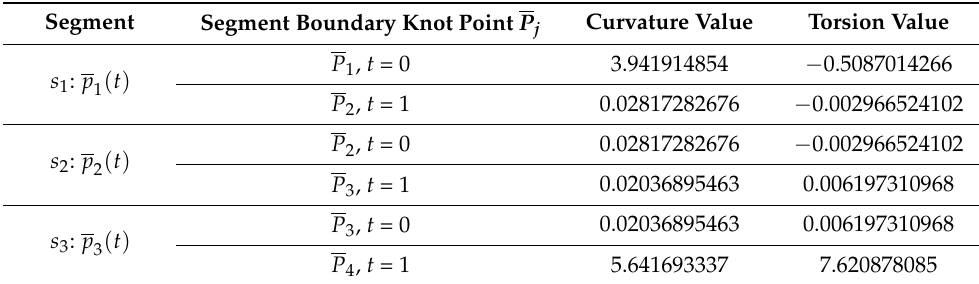
Table 1. Curvature and torsion values at boundary points of the segments.